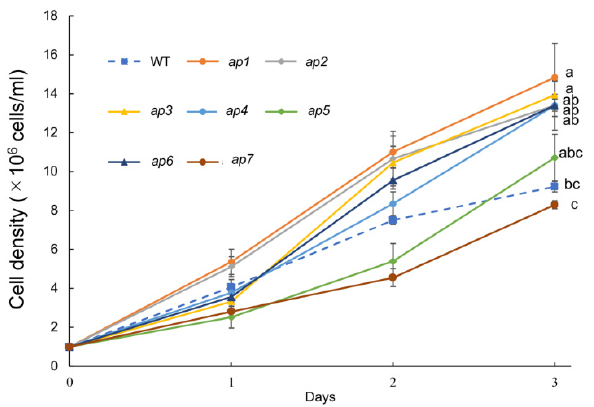
Figure 2. The growth phenotype of ap mutants. Precultured cells were collected and suspended in a fresh medium at 1 × 10 6 cells/mL (day 0) and subjected to culture under 30 μ mol photons m − 2 s − 1 white light. Cell density was measured every day and means ± S.E.M. (n = 3) are shown. Different letters indicate significant differences ( p < 0.05, one-way ANOVA and Tukey’s honest significance difference (HSD)).